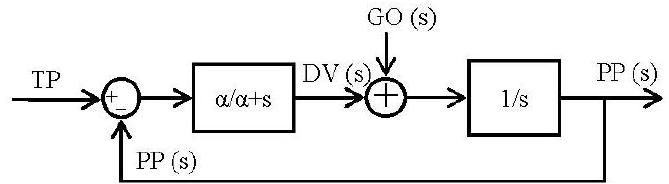
Figure 4. Block diagram resulted from the conversion of the VITE algorithm using the Laplace transformation. The low pass filter (with single gain) block avoids abrupt changes in the error signal and the integer block performs the robotic platform tasks. This block simulates the robotic platform and therefore it makes possible non-feedback from the robot. The robot is supposed to reach the commanded position.